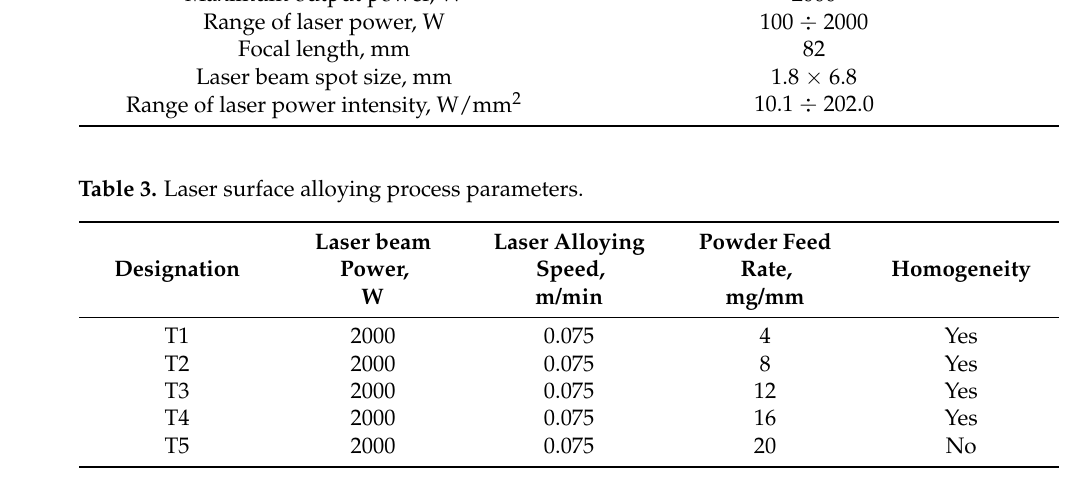
Table 2. Technical specifications of HPDL Rofin Sinar DL02 diode laser. Manufacturer The wavelength of the laser radiation, nm